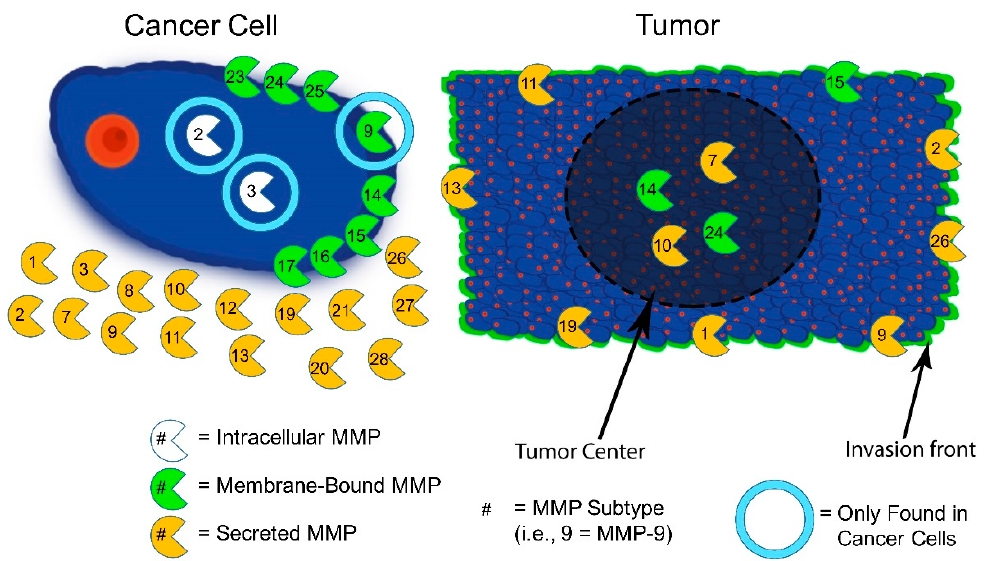
Figure 1. Schematic depicting the distribution of matrix metalloproteinase (MMP) subtypes within the tumor microenvi- ronment. The cancer cell on the left, depicts intracellular MMPs (shown to the right of the nucleus, represented in red), membrane-bound MMPs, and secreted MMPs. Additionally, the light blue circle indicates those MMPs that are found in that particular location only in cancer cells (e.g., MMP-2 is found intracellularly in cancer cells, but not in healthy cells). The tumor microenvironment on the right (depicted with a background of cancer cells for schematic representation) shows the distribution of MMPs within the tumor microenvironment, indicating those present near the tumor interior versus near the periphery. Image adapted with permissions from Isaacson et al., 2017 [25].